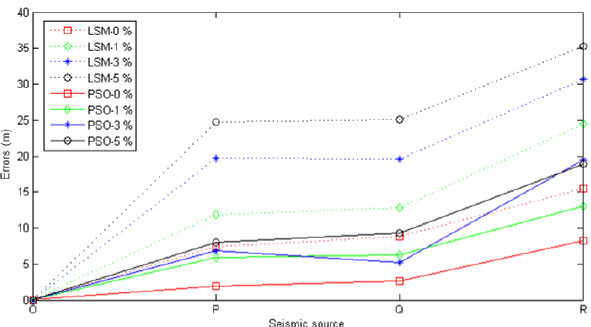
Figure 7. Comparison of locating errors between PSO method and LSM at different wave